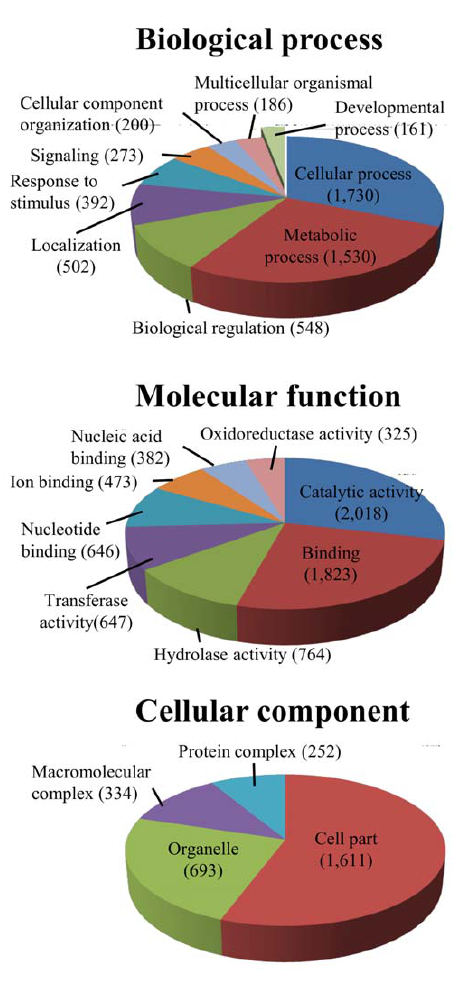
Figure 1. Most prominent GO terms assigned to the M. rosebergii developmental transcriptome. The most prominent GO terms assigned to level 2 of biological processes (top) and levels 2 and 3 of molecular functions (middle) and cellular components (bottom) are listed, as calculated by Blast2GO software suite. A small fraction of 161 GO terms ( , 1.4%) are assigned to developmental processes.